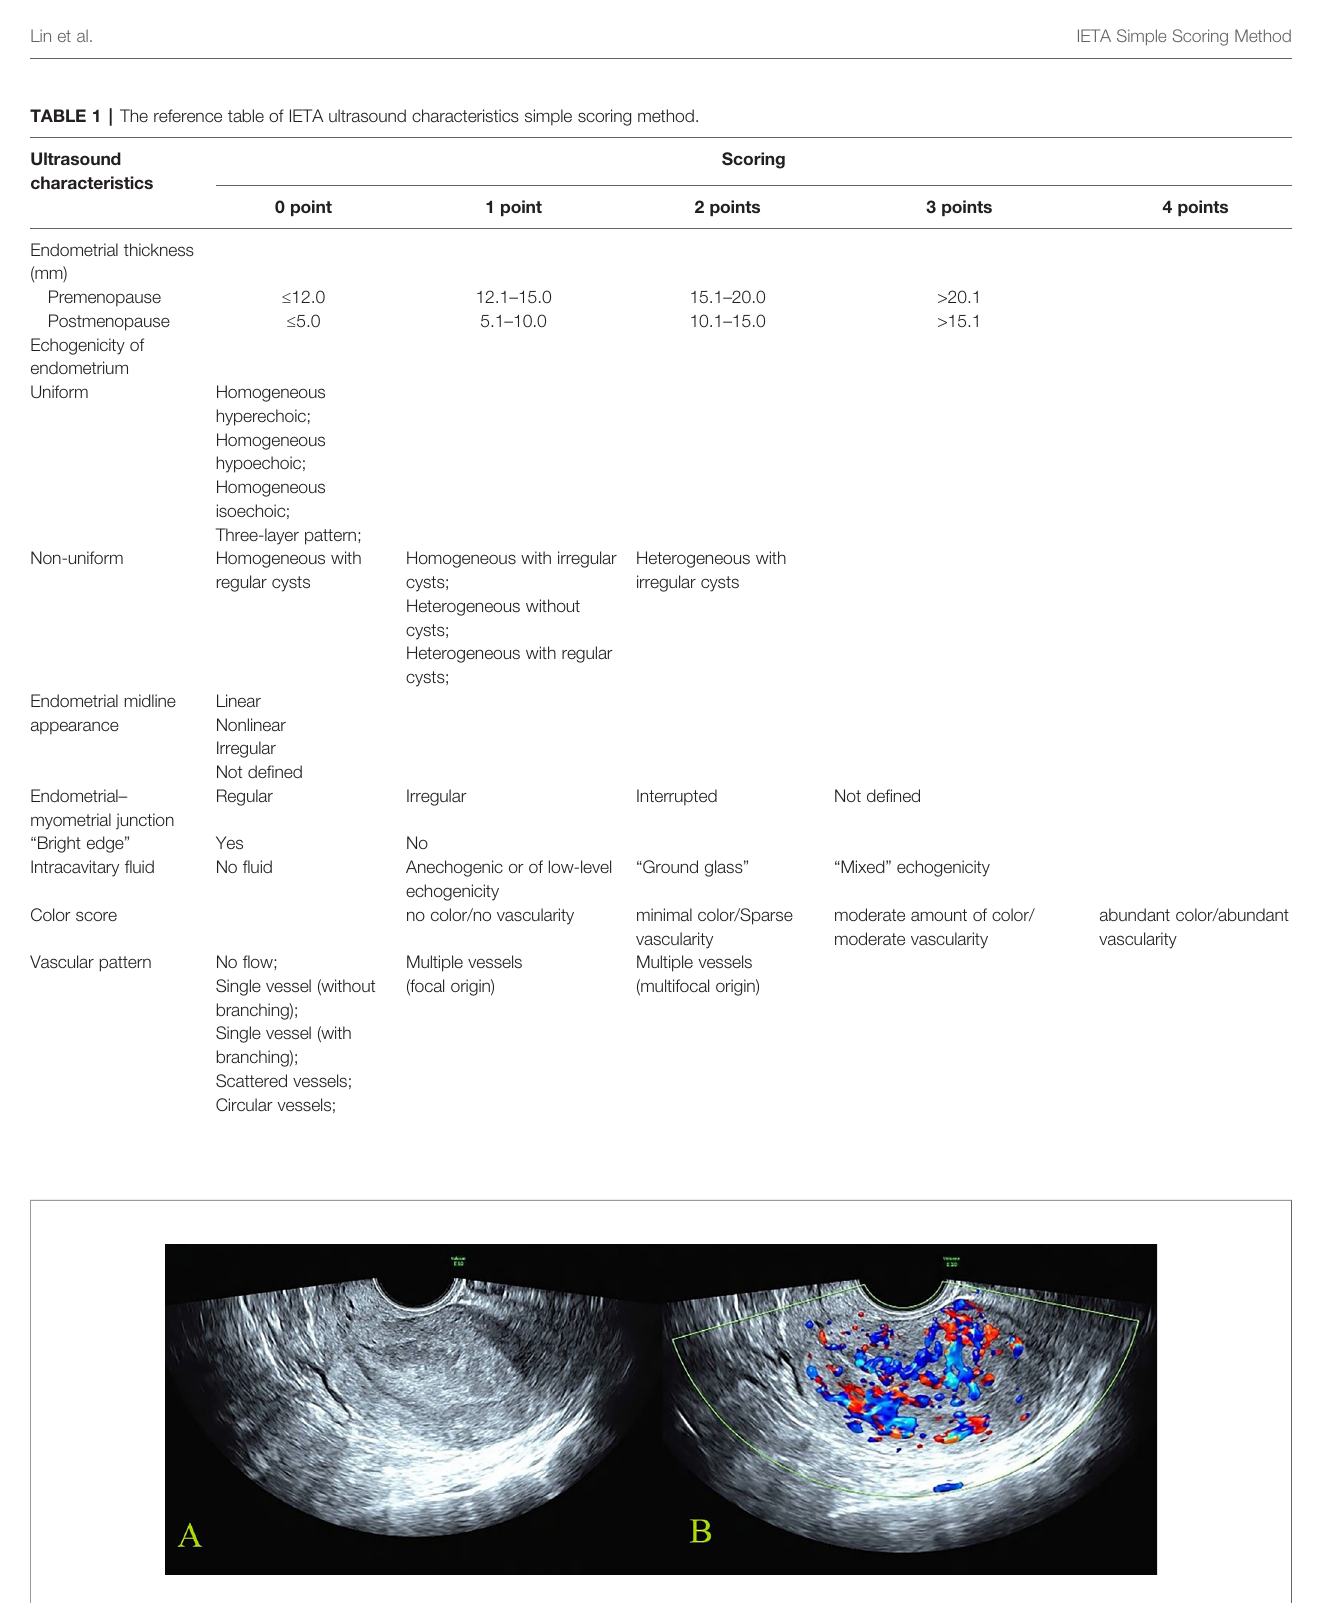
FIGURE 1 | Malignant reference case: female, 56 years old, postmenopause, irregular vaginal bleeding for more than 6 months; CA125, CA19-9, and HE4 were all increased. The postoperative pathology was stage IIIC1 of endometrioid adenocarcinoma. The total score of IETA ultrasound characteristics simple scoring method was 13 points [endometrial thickness 27 mm: 3 points; heterogeneous without cysts: 1 point; interrupted of endometrial – myometrial junction: 2 points; no “ Bright edge ” sign: 1 point; color score: abundant vascularity 4 points; multiple vessels (multifocal origin) pattern: 2 points]. (A) The grayscale image of endometrial lesion; (B) the color Doppler fl ow image of endometrial